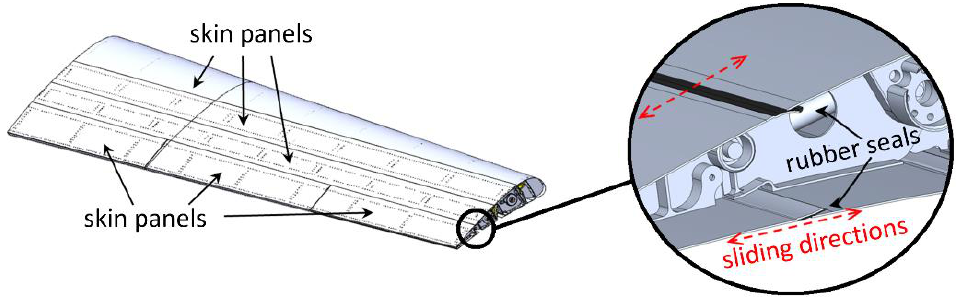
Figure 3 . Morphing flap, segmented skin layout . Figure 3. Morphing flap, segmented skin layout.